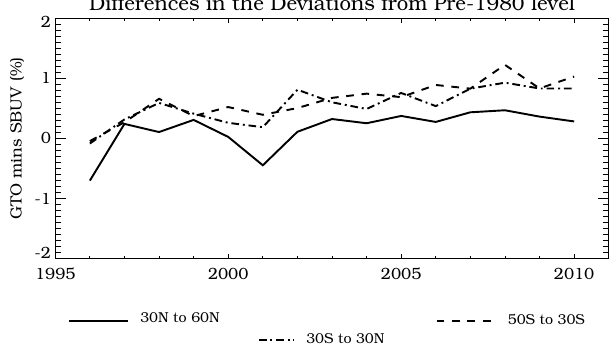
Figure 10. Differences in the deviations from pre-1980 level (GTO-